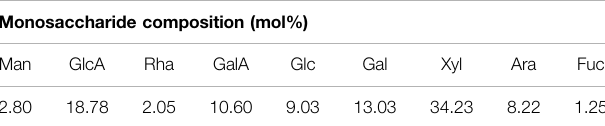
TABLE 1 | Chemical properties of